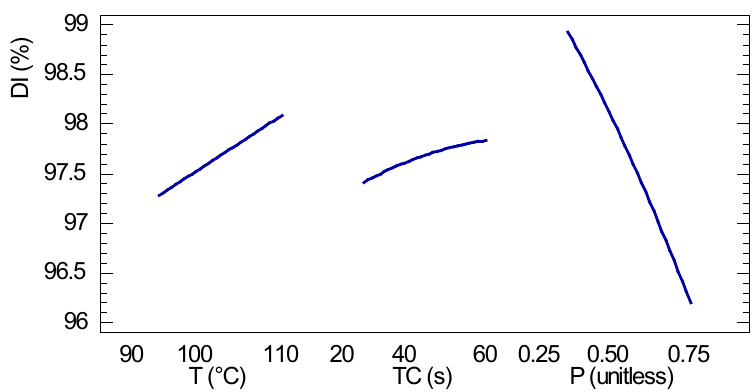
Figure 4. Main e ff ects for the mechanical durability index considering the experimental factors of process temperature, compaction time, and proportion of rice husk in the mixture.